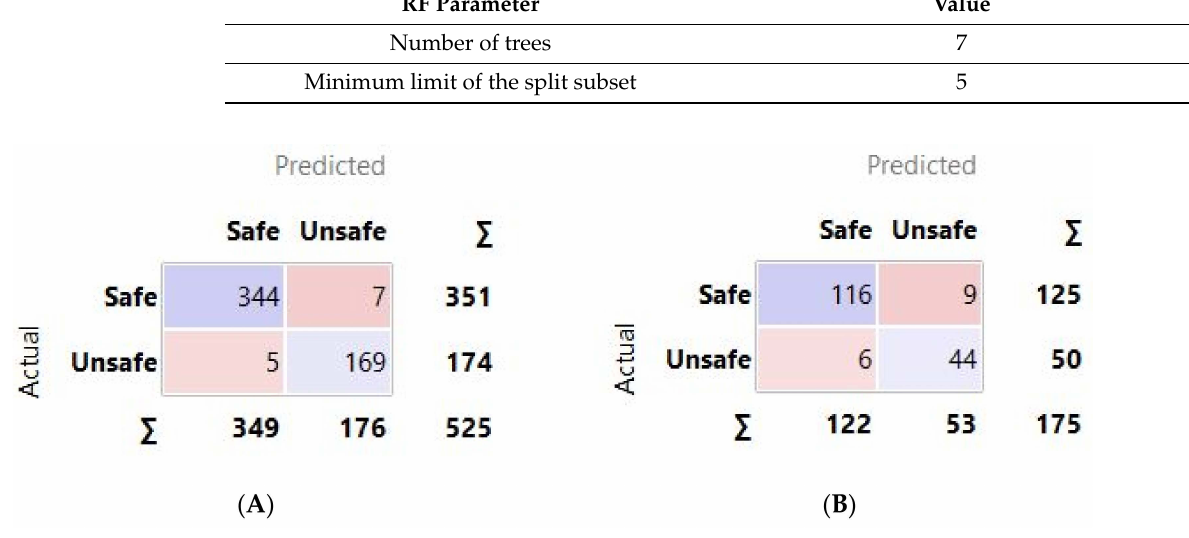
Figure 8. The RF model results for FOS classification: ( A ) Training and ( B ) Testing.